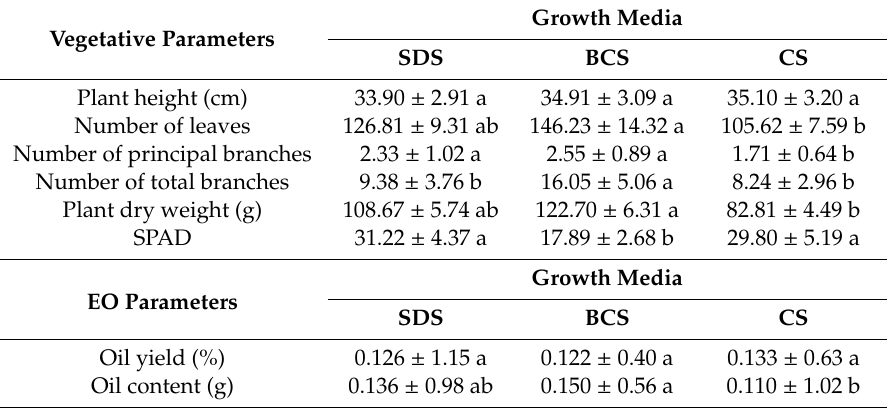
Table 2. E ff ects of growth media on vegetative parameters and essential oil response in P. graveolens cultivation. All the values are means of three replicates ± standard deviation. SDS, solid digestate growth media; BCS, biochar growth media; CS, control growth media; SPAD, soil plant analysis development; EO, essential oil.